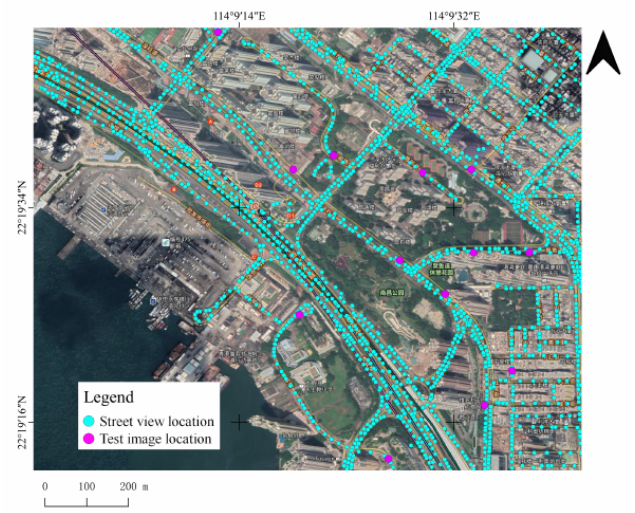
Figure 3. Distribution of part of our Hong Kong street-level image dataset and part of our test data set on satellite